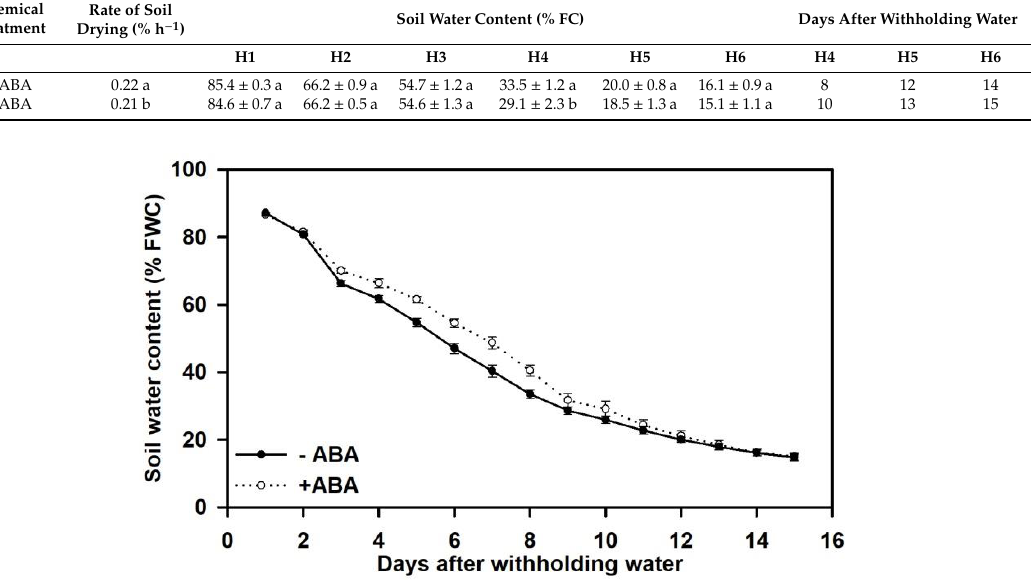
Figure 1. Changes in soil water content over time (days) after withholding water. One day before withholding water, plants were pretreated with (+ABA) or without (−ABA) 10 µM exogenous ABA. Values are the mean ± SE ( n = 3).